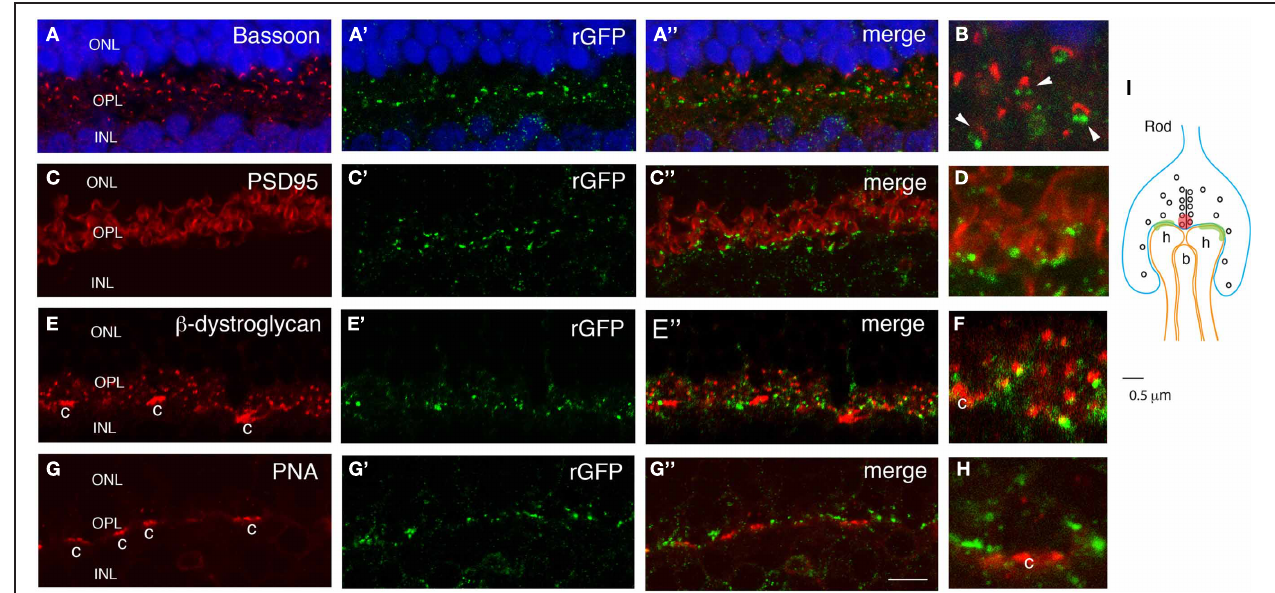
which marks perisynaptic regions widely within rod terminals. (E,F) GFP-positive puncta are apposed to sites labeled with anti- β -dystroglycan, which marks perisynaptic regions within rod terminals. β -dystroglycan is also present in cone terminals (c). (G,H) GFP-positive puncta are absent from sites labeled with Peanut agglutinin-positive, which marks cone photoreceptors terminals (c). This arrangement suggests that GRASP signals are present at synapses of rod but not cone photoreceptors on horizontal and bipolar cell processes. (I) A sketch of a rod spherule. Two horizontal cell dendrites (h) directly contact a rod terminal, and a bipolar dendrite (b) is distant from a synaptic ribbon. Bar, 3 μ m for A,C,E,G ; 1 μ m for B,D,F,H